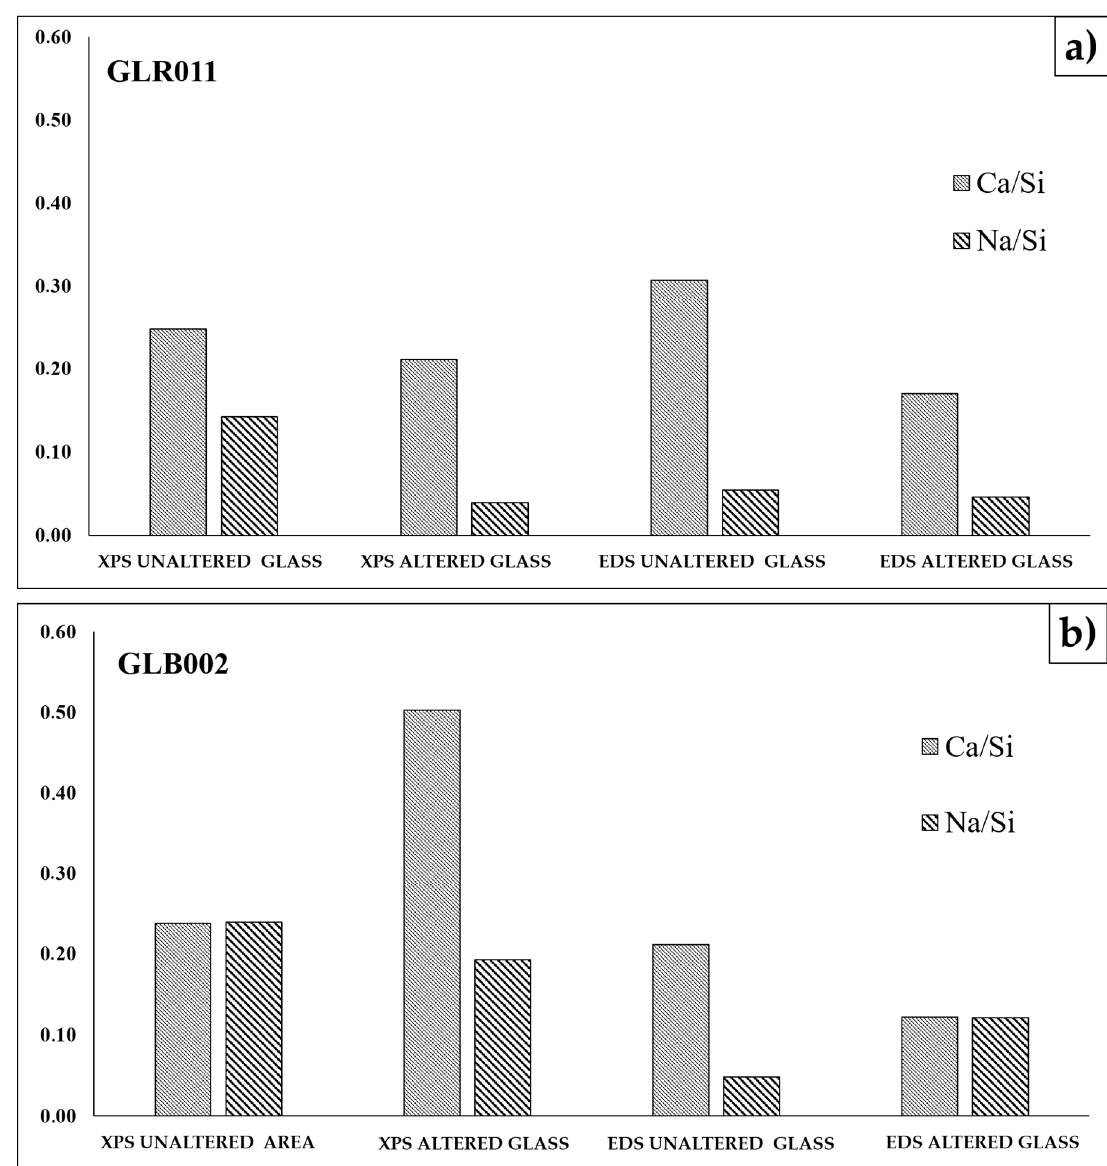
Figure 11. Ca/Si e Na /Si ratios obtained from XPS and EDS analyses carried out on unaltered and Figure 11. Ca / Si e Na / Si ratios obtained from XPS and EDS analyses carried out on unaltered and altered glass areas for samples GLR011 (a) and GLB002 (b). altered glass areas for samples GLR011 ( a ) and GLB002 ( b